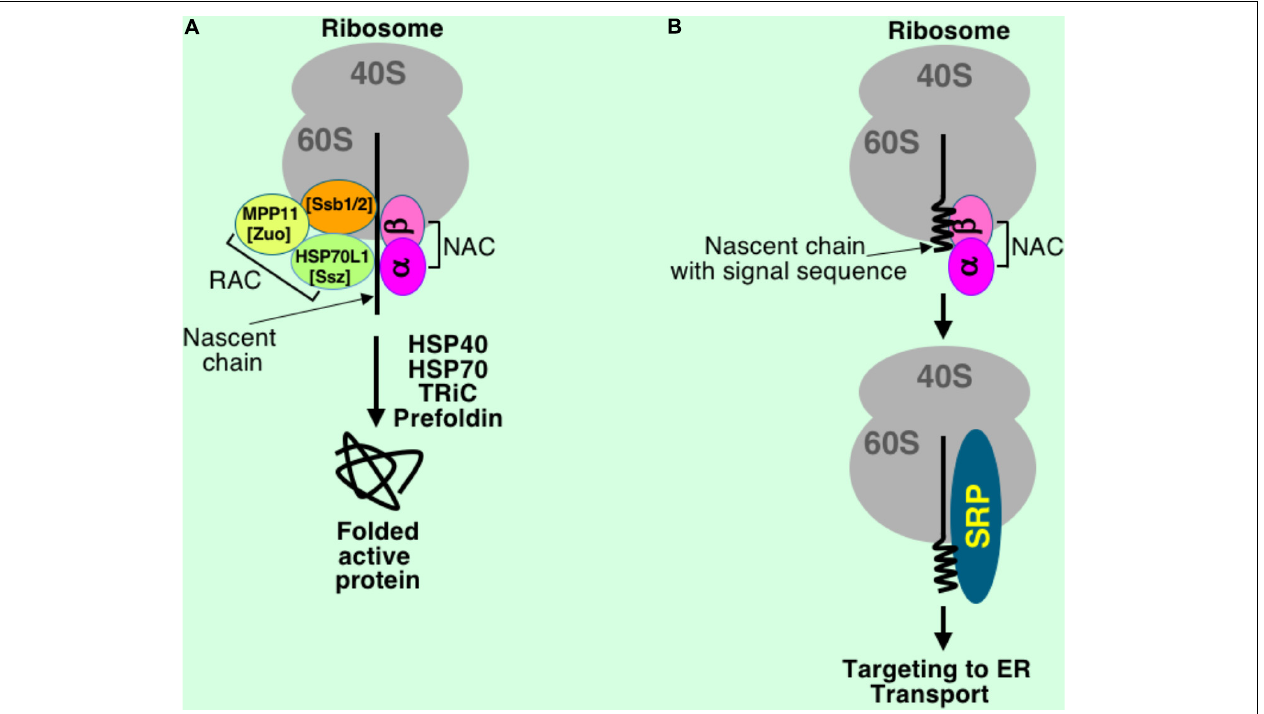
FIGURE 2 | Simplified scheme of interactions at the polypeptide exit site at the ribosome under normal conditions. Nascent chains and ribosomes interact with different proteins during translation to achieve proper folding and correct targeting. While nascent chains of cytosolic proteins (A) are synthesized in environment of RAC, NAC, Ssb (HSP70) and further folded with assistance of chaperones and chaperonins, the secretory proteins (B) briefly interact with NAC before full exposure of the signal sequence, and when signal sequence is emerged from the ribosome tunnel, SRP binds it leading to temporary elongation arrest and targeting to the ER membrane for further transport through translocon into ER lumen, then to Golgi, and finally outside of the cell. Only major interacting partners are shown, their sizes are not to scale, and their positions on the ribosome and contacts are presented for a general understanding of the process and do not reflect very complex nature of their interactions with the nascent chains and the ribosomes. Mammalian proteins are shown, their yeast counterparts are in square